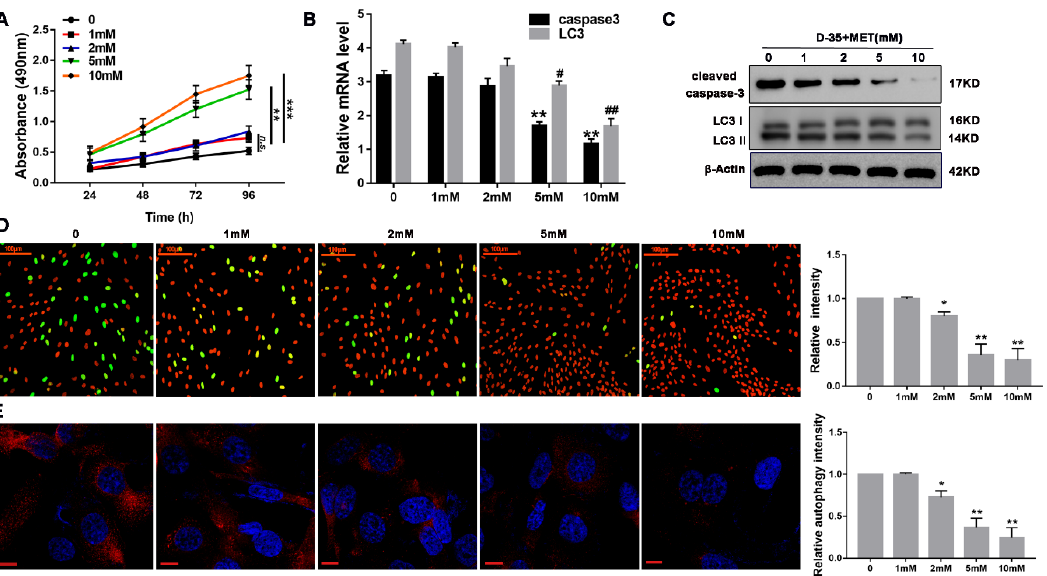
Figure 3. Diane-35 and metformin repressed ovarian granulosa cells apoptosis in a murine model of PCOS. Ovarian granulosa cells were isolated from mice ovaries. Then, cells were treated with increasing concentrations of Diane-35 and metformin (0, 1, 2, 5, and 10 mM) for 24 h. A CCK-8 assay was performed to measure cell viability ( A ). RT-PCR ( B ) and Western blotting ( C ) were used to detect cleaved caspase-3 and LC3 expression in granulosa cells. Granulosa cells apoptosis was determined by the Tunel assay, scale bars = 100 µ m ( D ). Immunofluorescence assay was performed using LC3 I/II antibody, red for LC3, scale bars = 10 µ m ( E ). Data are shown as the mean ± S.D., n = 3. n.s. = no statistically significant differences. * p < 0.05, # p < 0.05, ** p < 0.01, ## p < 0.01 and *** p < 0.001,